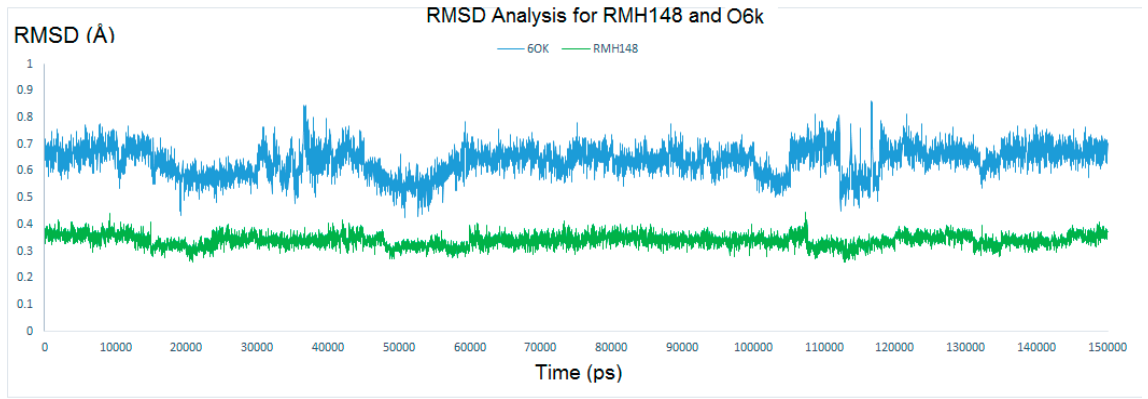
Figure 6. The RMSD of RMH148 in green and O6k in blue. Table 1. The average distances of all hydrogen bonds formed between RMH148 and COVID-19 Mpro through the entire 150 ns MD simulation.